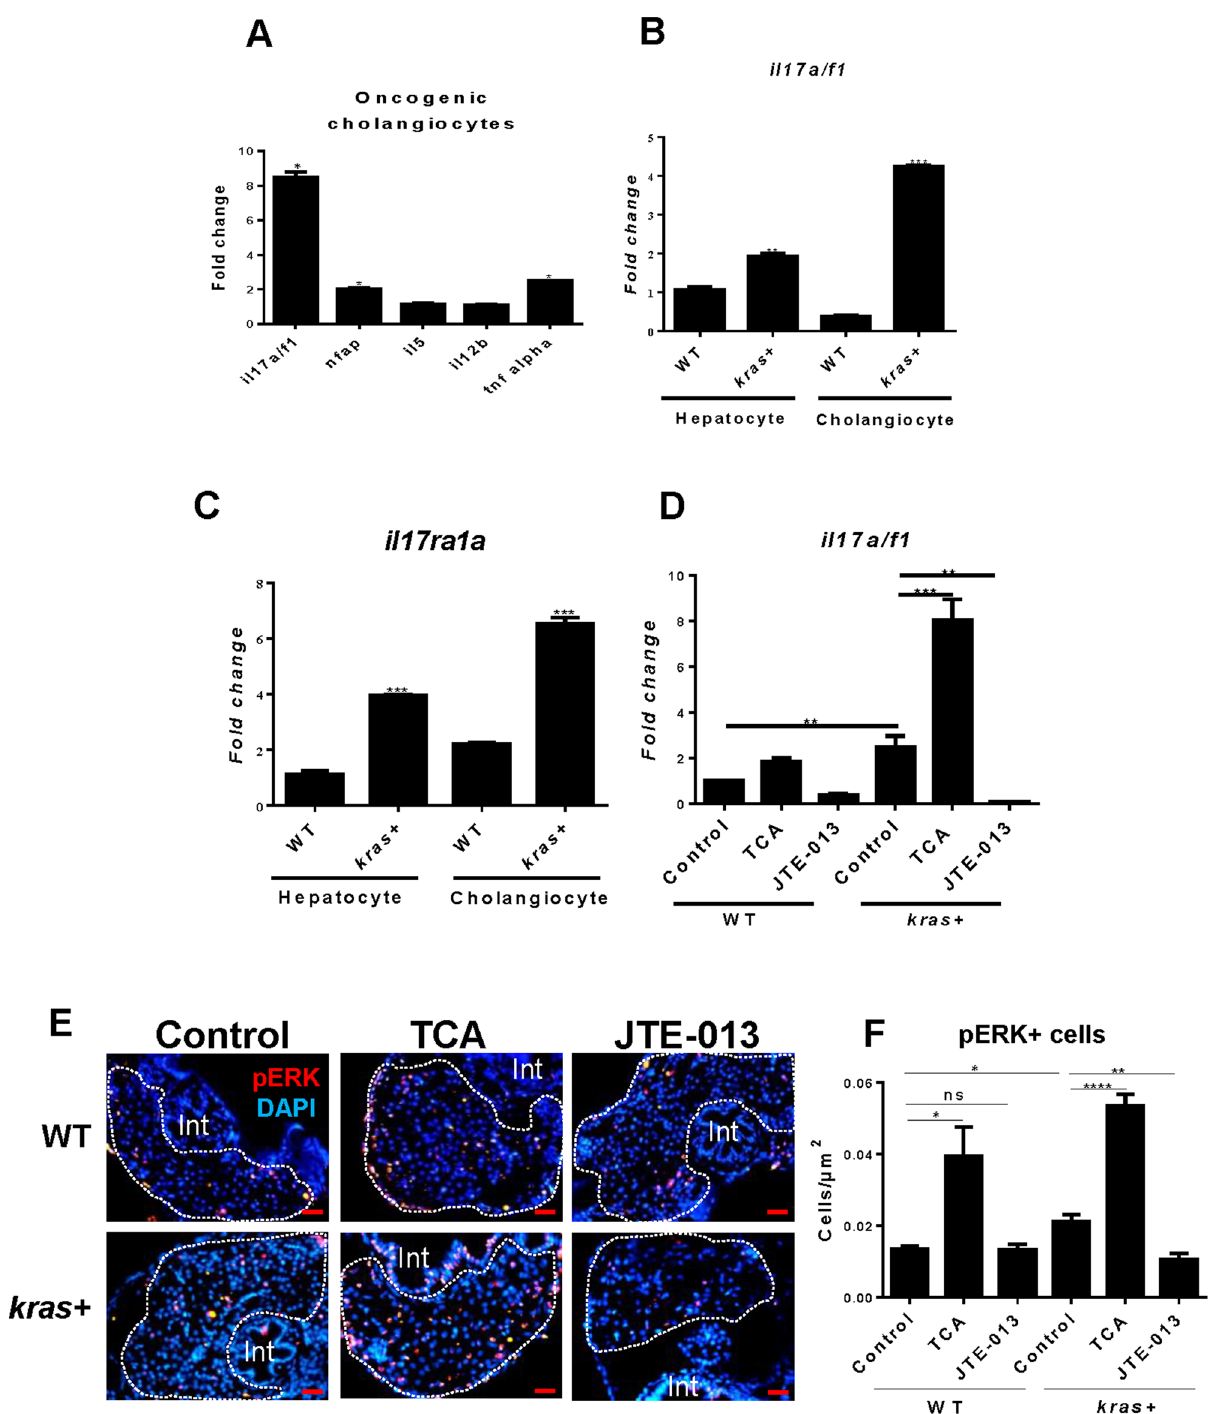
Figure 5. Expression of selected cytokine mRNAs in hepatocytes and cholangiocytes of the liver in adult zebrafish. ( A ) Expression of selected cytokine mRNAs in cholangiocytes upon kras induction in hepatocytes. ( B , C ) Expression of il17a/f1 ( B ) and il17ra1a mRNAs in cholangiocytes and hepatocytes in WT and kras + larvae following Dox induction from 3 to 8 dpf. ( D ) Expression of il17a/f1 mRNA in kras + and WT larvae treated with TCA and JTE-013 together with Dox from 3 to 8 dpf. In ( A ), gene expression values in the kras groups were normalized to their WT counterparts. In ( B – D ), all values were normalized to WT hepatocyte value. ( E , F ) Representative images of il17a/f1 downstream maker p-ERK staining ( E ) and quantification of pERK stained cells ( F ) in kras + and WT zebrafish larvae treated with TCA and JTE-013 from 3 to 8 dpf. N = 10 per group. Scale bars, 20 μm Statistical significance: *P ˂